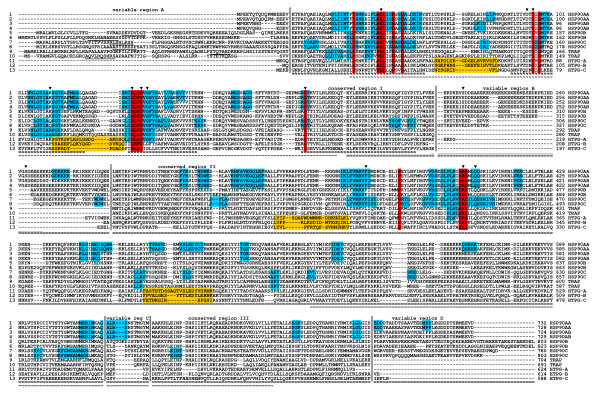
Alignment of representative amino acid sequences of the HSP90 family of proteins, showing their conserved/variable regions, functionally important residues, and functional domains. Amino acid residues completely conserved throughout the HSP90 family are shaded in red, and those conserved throughout each subfamily are in green. The regions that distinguish HTPG Groups A, B and C are shaded in yellow. Gaps are marked with"-", the last residue in each line is assigned a number and subfamily names are indicated at the end of each line. The conserved/variable regions are separated by "||" with the names above the alignment, and the cleavage sites located just before the underlined residues. "▼" stands for the functionally important residues experimentally identified: E47 (refers to HSP90AA1) for ATP hydrolysis; D93 for ATP binding [33]; G95, G132, G135, G137, and G183 for both GA and p23 binding; K112 for GA binding [72]; R400 and Q404 for ATPase activity; F369 for interdomain interaction [63]; S231 and S263 for phosphorylation by casein kinase II [74]. The conserved and functional domains are indicated by: "≈" for HSP90 protein family signature; "=" for HSP90 protein; "~" for histidine kinase-like ATPases; "∞" for four-helical cytokine; and "..." for Glutamic acid-rich region. The number of each sequence represents: 1. (HSA)HSP90AA1, 2. (GGA)HSP90AA1, 3. (HSA)HSP90AB1, 4. (GGA)HSP90AB1, 5. (HSA)HSP90B1, 6. (ATH)HSP90B1, 7. (ATH)HSP90C1, 8. (ATH)HSP90C2, 9. (HSA)TRAP1, 10. (DME)TRAP1, 11. (ECO)HTPG1, 12. (BFR)HTPG1.